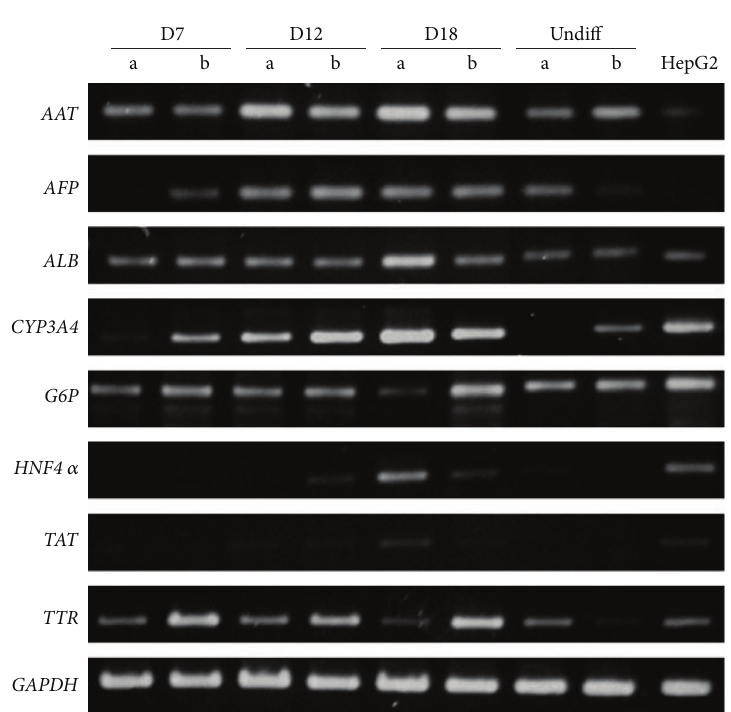
Figure 3: Hepatic-specific gene expressions of the differentiated cells after induction for 18 days. Total RNA was isolated from MSCDHCs generated from WJMSCs-SUT1 (lane a) and WJMSCs-SUT2 (lane b) following the differentiation period, and mRNA expressions of hepatic- specific genes were analyzed by RT-PCR. HepG2 was used as positive control. GAPDH was used as an internal